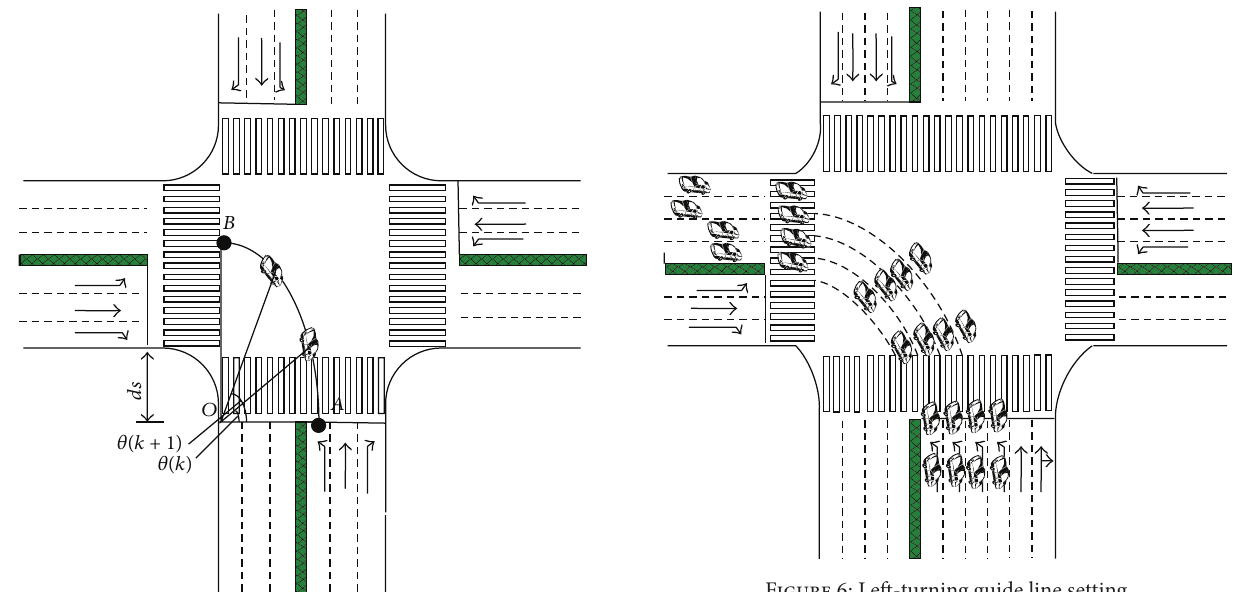
Figure 6: Left-turning guide line